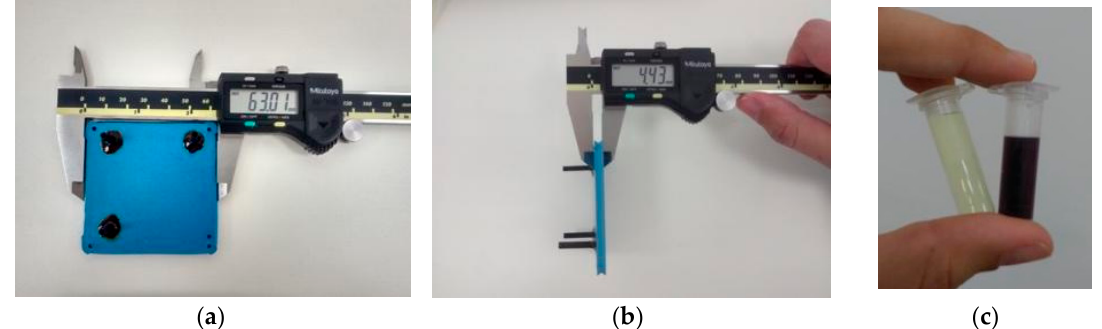
Figure 16. ( a , b ) Microfluidic device fabricated with LTCC technology employed on synthesis of gold nanoparticles; ( c ) Gold (III) salt used in nanoparticles synthesis (left) and gold nanoparticles obtained through flow conditions (right).